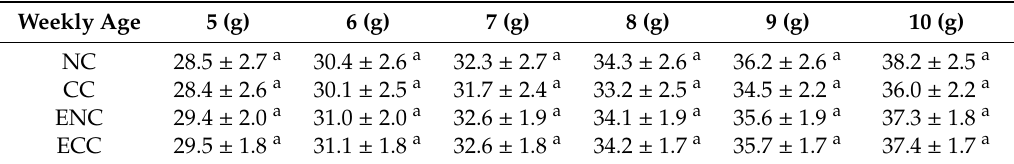
Table 5. Body weights of ICR